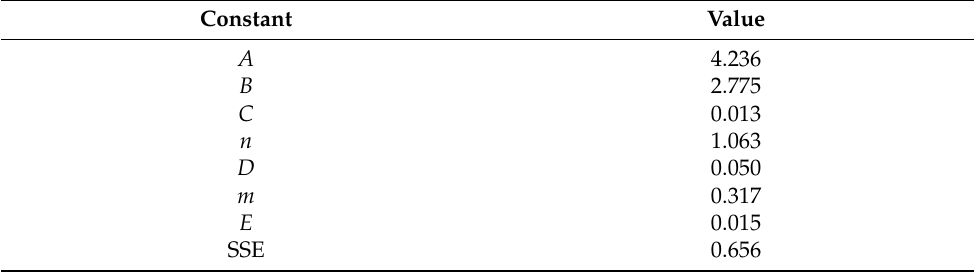
Figure 12. Corrected flame heights and associated 95% confidence intervals of experiments with three pads. Lines are best overall fit correlations using Equation (9). Configurations are shown in Figure 2. Table 5. Curve-fit constants for correlation of three-pad FH data (Equation (9)).